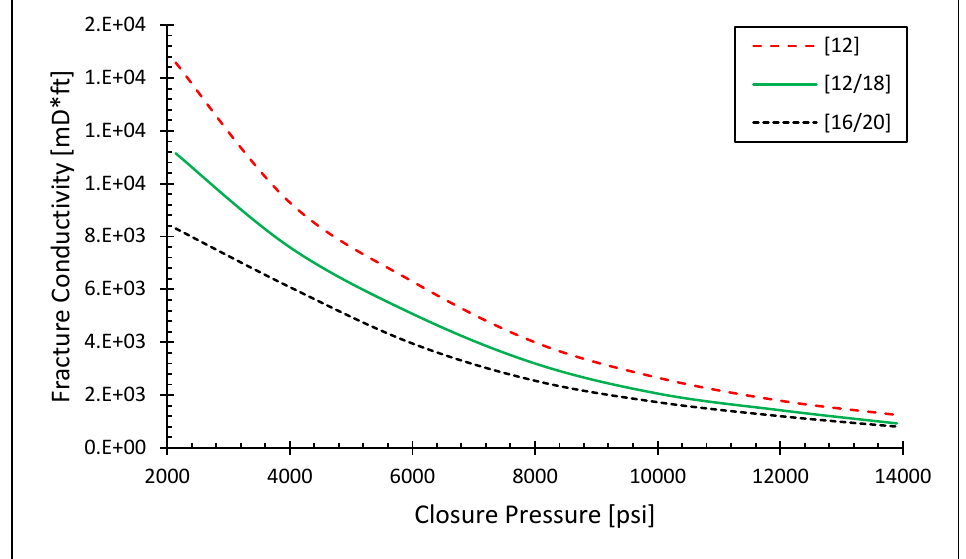
Figure 17. Fracture conductivity as a function of closure pressure.